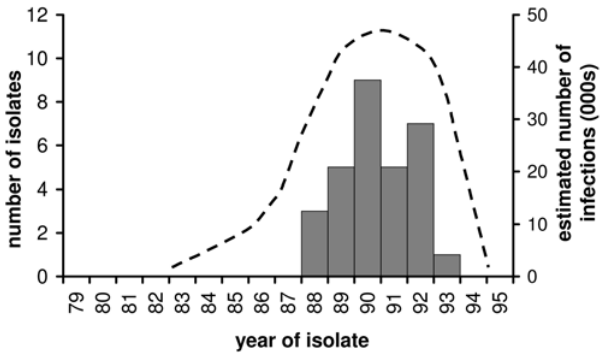
Figure 7. The distribution of reported cVDPV cases in Egypt (grey bars) is shown on the left hand axis. The estimated number of infections (dotted line) between 1983 (when the initiating infection is estimated to have occurred) and the end of the outbreak is plotted against the right hand axis, and represents a best estimate of the distribution of infections. The approximation for the number of infections is represented by the area under the curve, and assumes a constant case to infection ratio of 1:1000, and average case ascertainment of , 10%.